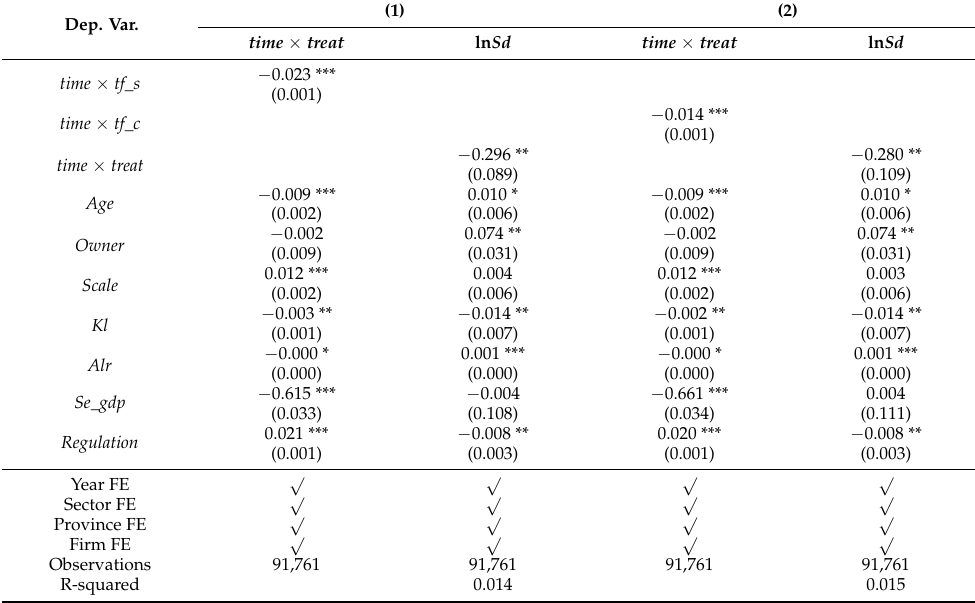
Table 11. Test for endogeneity. Dep.